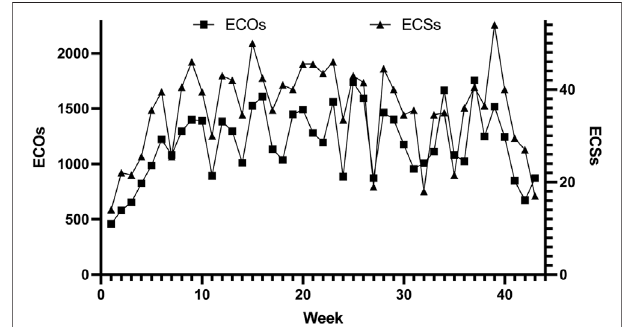
FIGURE 1 | Weekly subjective training load (ECSs) related with the objective training load (ECOs).